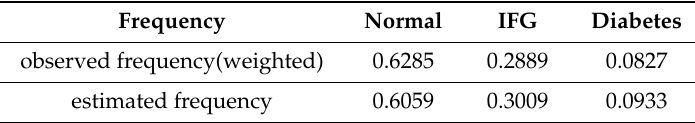
Table 3. Relative frequency of each FBG category.